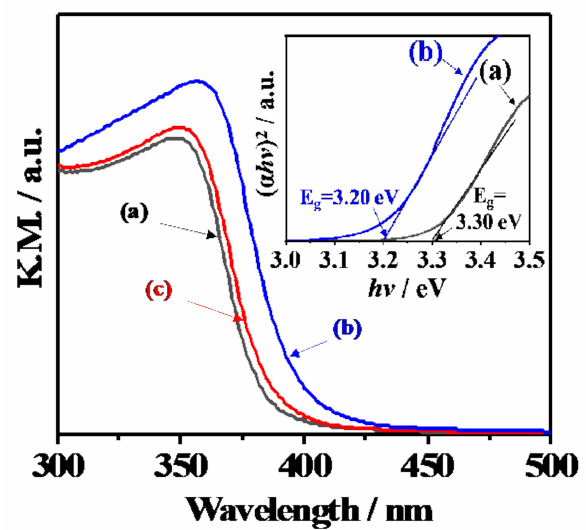
Figure 5. UV-Vis diffuse reflectance spectra of 1573K-Pure-CeO 2 ( a ), 1573K-CPT-30.0YDC ( b ), 1573K- SSR ( c ) and corresponding Tauc